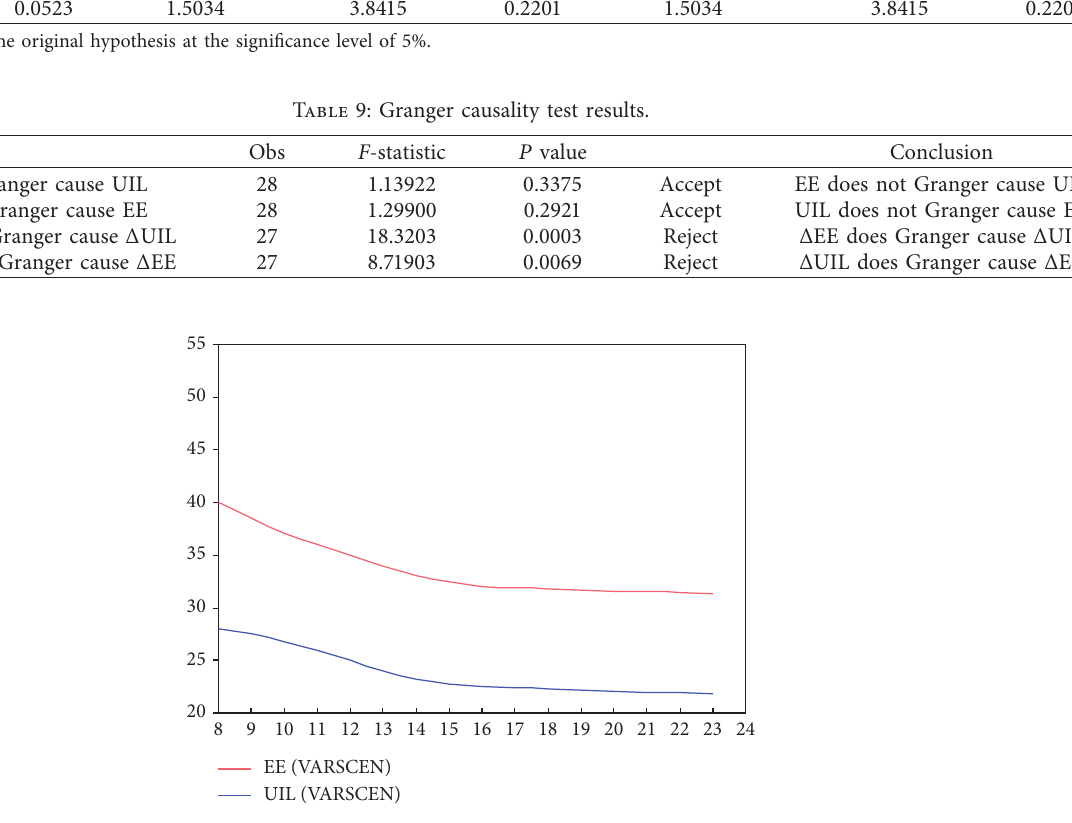
Figure 4: Granger causality test of urban innovation level and ecological efficiency based on first-order difference.